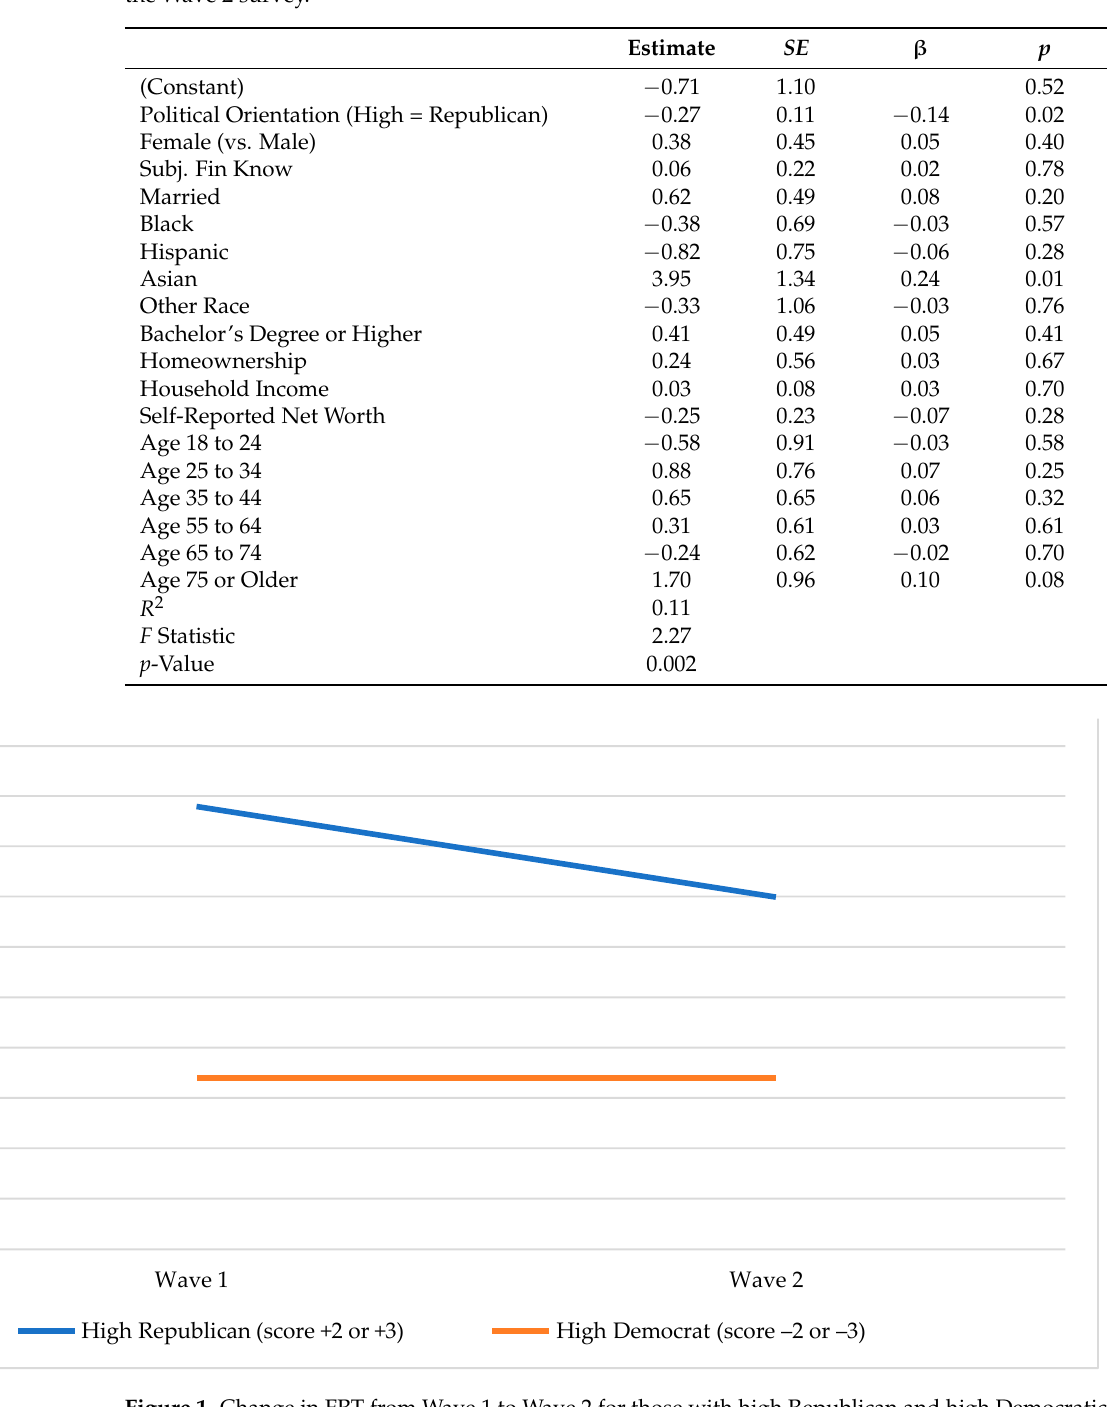
Table 6. OLS regression results describing change in financial risk tolerance (FRT) from the Wave 1 to the Wave 2 survey.